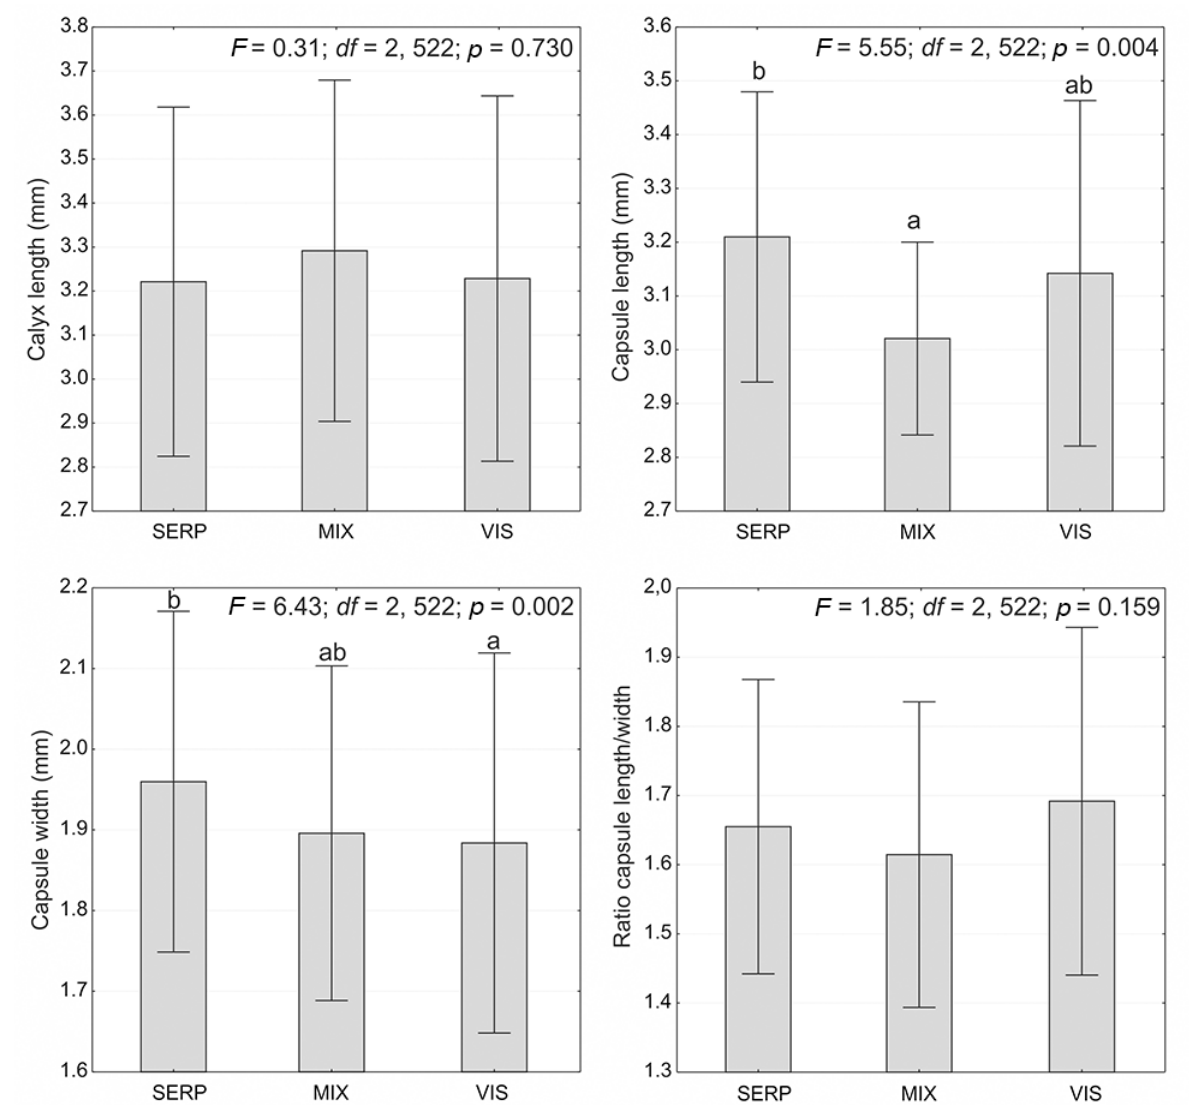
Fig. 3 Quantitative characters (means ± SD ) of studied morphotypes (VIS, MIX, SERP). Results of ANOVA ( p < 0.05): F and p values are provided. Letters denote the results of Tukey’s (HSD) test; different letters indicate significant differences at the p < 0.05